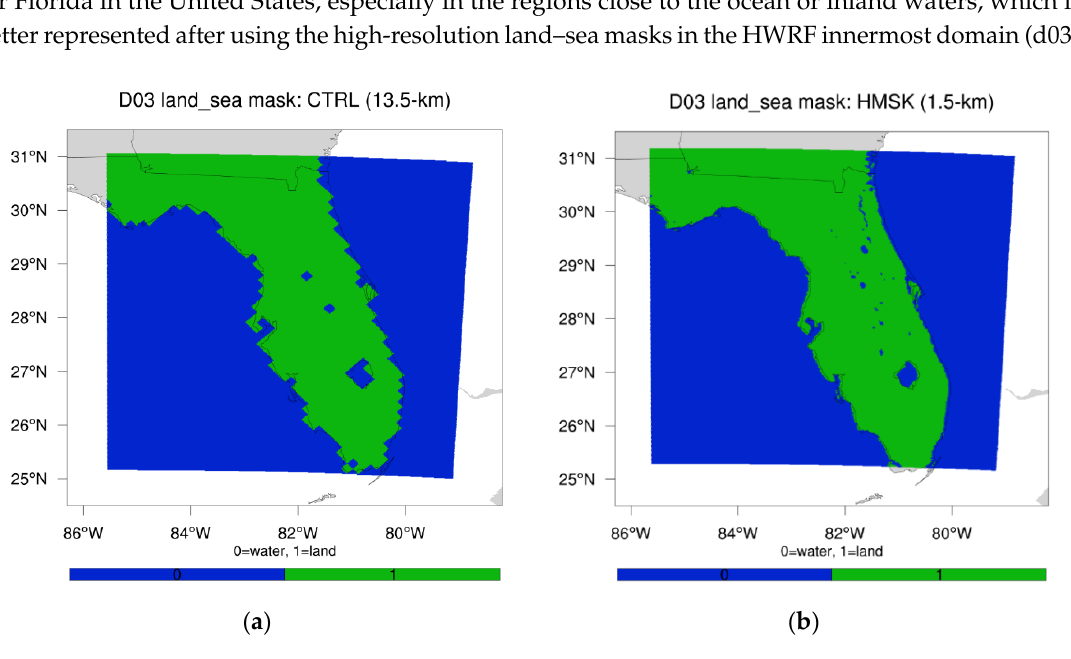
Figure 4. The distribution of the land–sea masks for the innermost domain (d03) covering the state of Florida is shown in the Hurricane Irma (2017) case study before / after introducing the high-resolution land–sea mask into HWRF. The date for this simulation cycle is at 0000 UTC 11 September 2017. ( a ) The land–sea mask’s resolution in d03 is the same as the parent domain (d01, 13.5 km) in the FY18 HWRF. ( b ) The land–sea mask’s resolution in d03 is 1.5 km after applying the high-resolution land–sea mask method. The land–sea mask is dimensionless (0 = water; 1 = land).